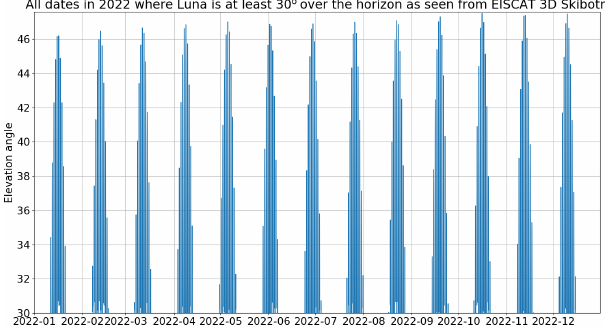
Table 3. Effect of the angle between the phase plane and the radar look direction on Doppler broadening, with α = 0 . 1, and TECu is equal to 40.